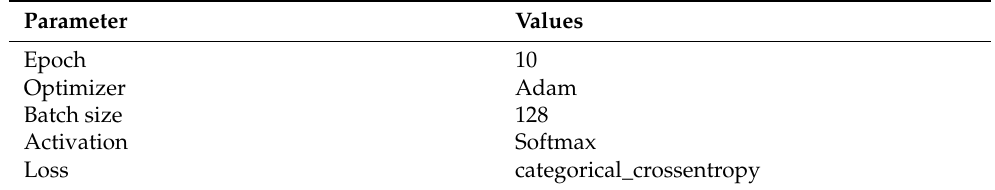
Table 5. Parameter setting of BiLSTM.